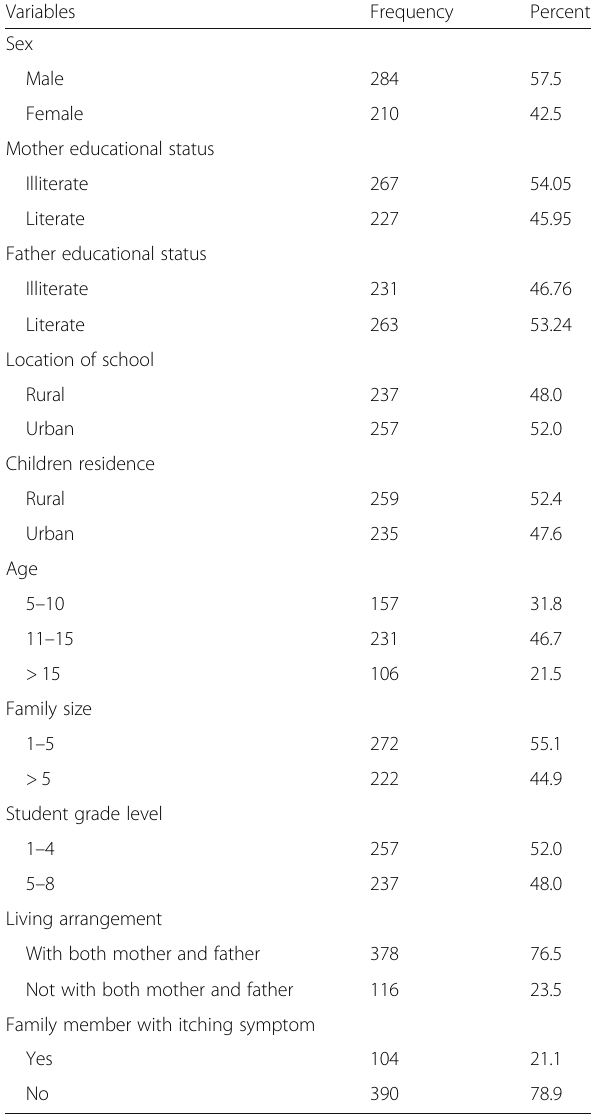
Table 1 Sociodemographic characteristics of students and their parents, Dabat district, Northwest Ethiopia, 2018 ( n = 494)